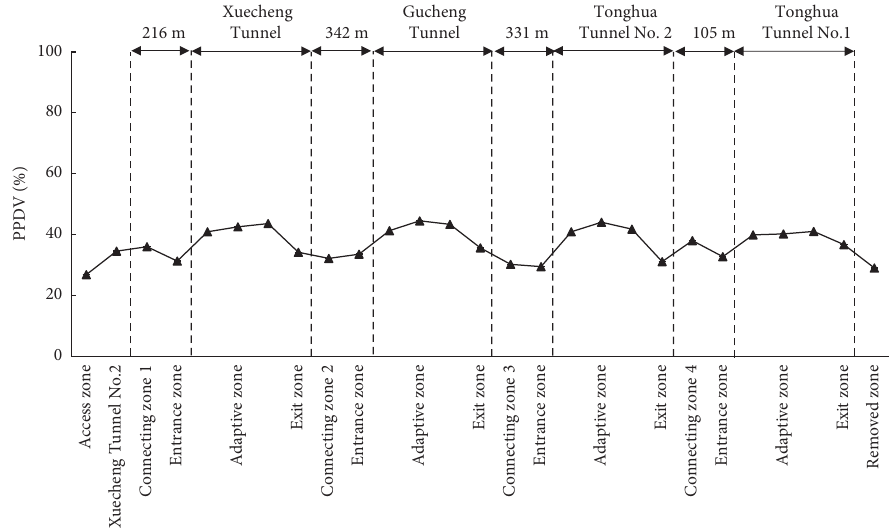
Figure 13: Zone analysis of Xuecheng-Tonghua Tunnel group. Table 5: Percentage correlation analysis of connecting zone length ( L